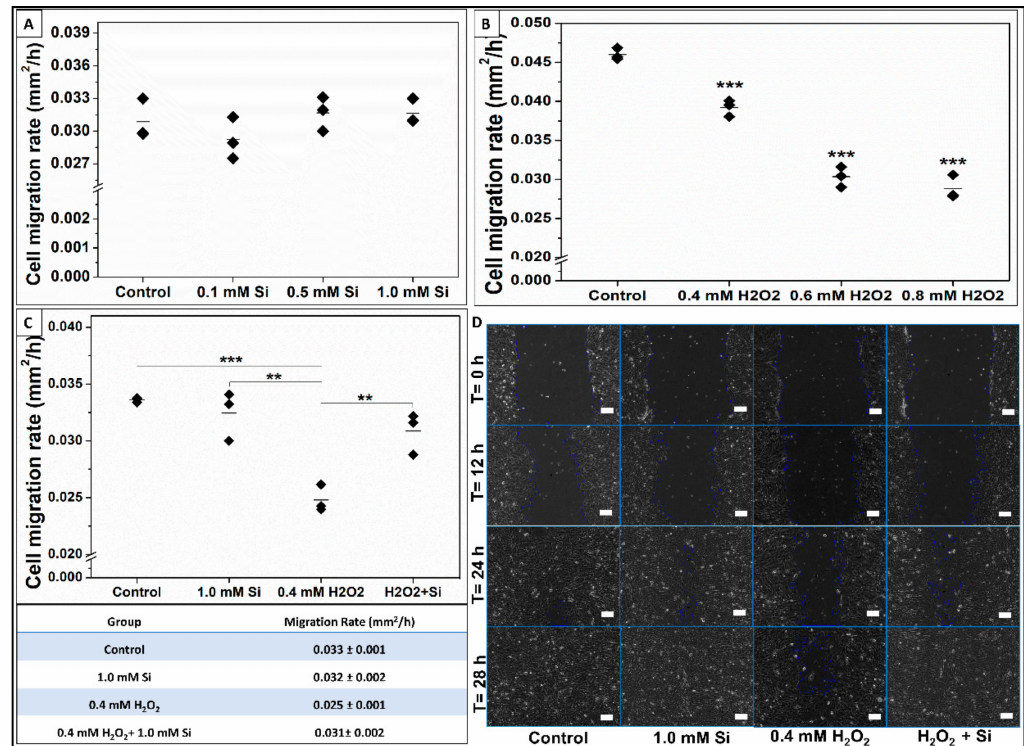
Figure 10. Si-ions significantly enhance muscle wound healing by increasing the cells’ migration rate under toxic oxidative stress condition. ( A ) Data presents the cell migration rate (mm 2 /h) of C2C12 myoblast cells under normal control and three concentrations of Si-ions. Growth media with 0.5–1.0 mM Si-ions enhances the cells’ migration rate. ( B ) H 2 O 2 significantly decreases the cells’ migration rate under the used concentrations (0.4, 0.6, and 0.8 mM H 2 O 2 ) (*** p < 0.001). ( C ) Si-ions attenuate the toxic effect of H 2 O 2 and significantly increase the cells’ migration rate under toxic oxidative stress condition. ( D ) Bright field images (10 × , scale bar = 100 µ m) show the wound/scratch area at different time points (0, 12, 24, and 28 h), (** p < 0.01, *** p <